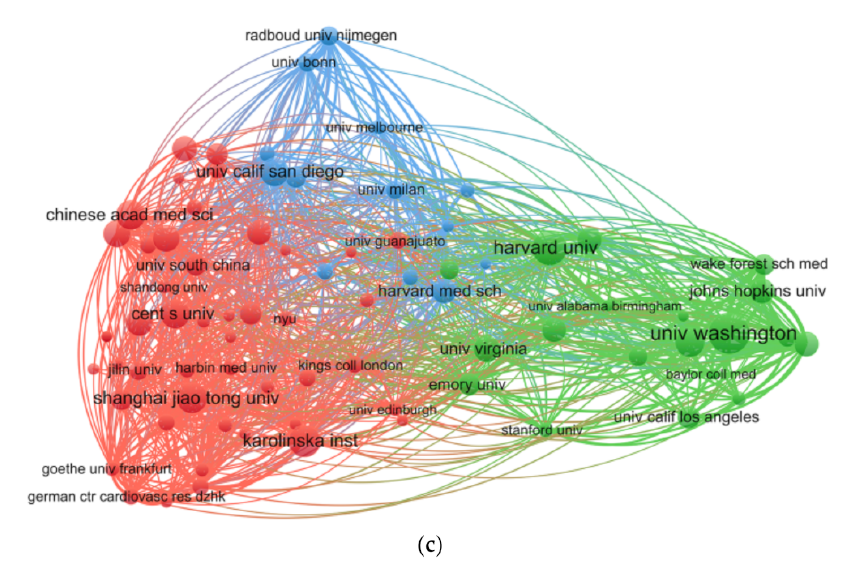
Figure 3. Bibliographic coupling analysis. ( a ) Coupling analysis chart of 48 journals with eight or more articles were analyzed. ( b ) Literature coupling analysis chart composed of 78 organizations with ten or more articles. ( c ) Literature coupling analysis chart of 29 countries with twelve or more articles. The line between two points in the figure shows that two journals, institutions, or countries had established a similarity relationship. The thicker the line, the closer the link between the two journals, institutions, or